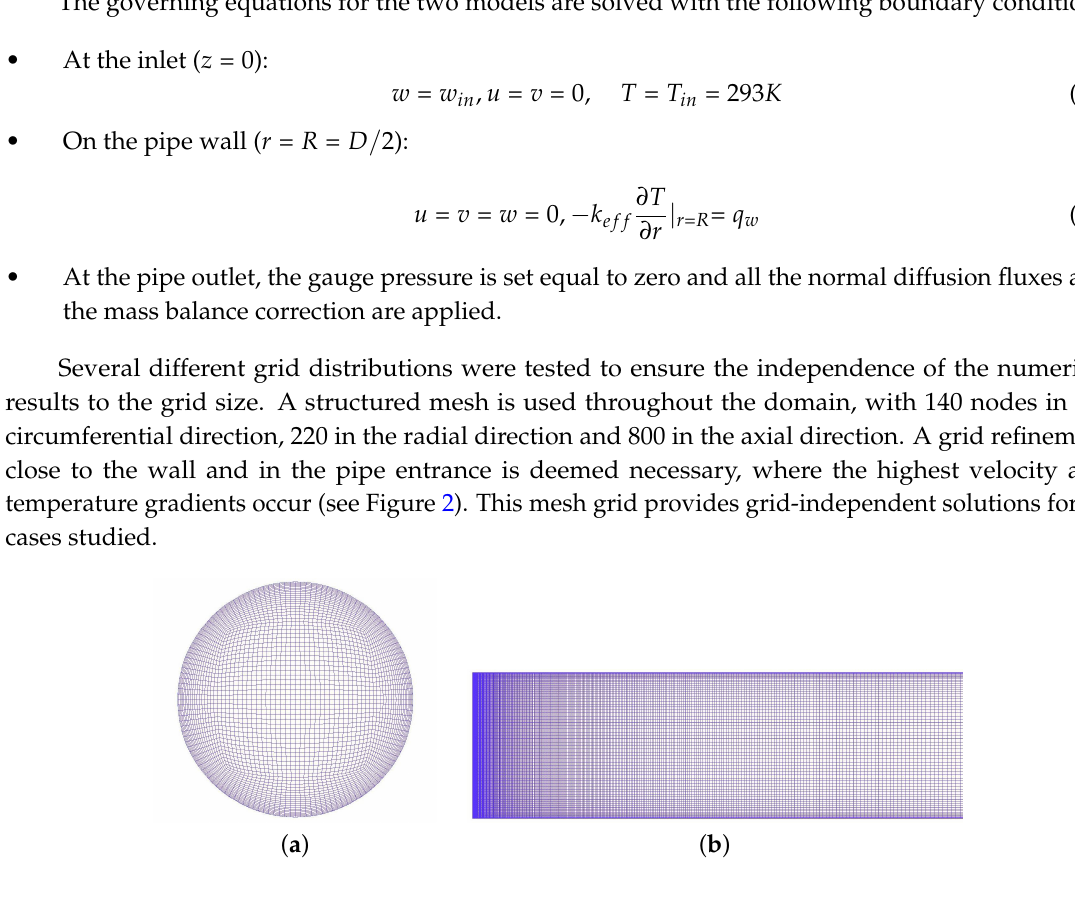
Figure 2. Schematic view of the mesh grid: ( a ) in a given cross-section; and ( b ) along the axial